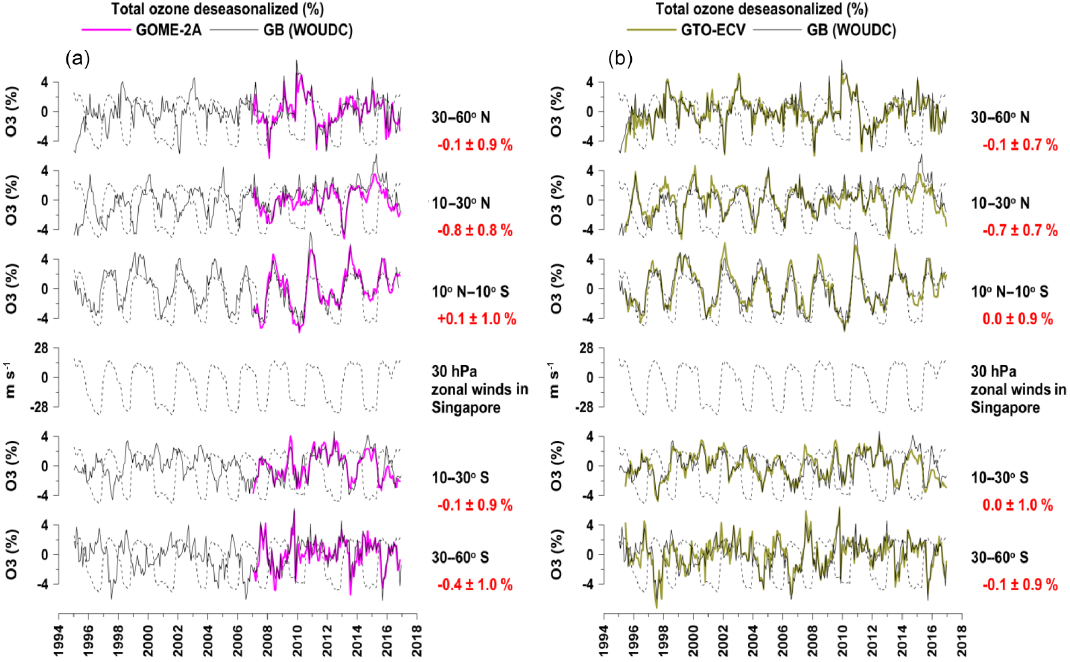
Figure 6. Same as in Fig. 5, but for GOME-2A and GB observations (a) and for GTO-ECV and GB observations (b) . The QBO proxy is superimposed on the ozone